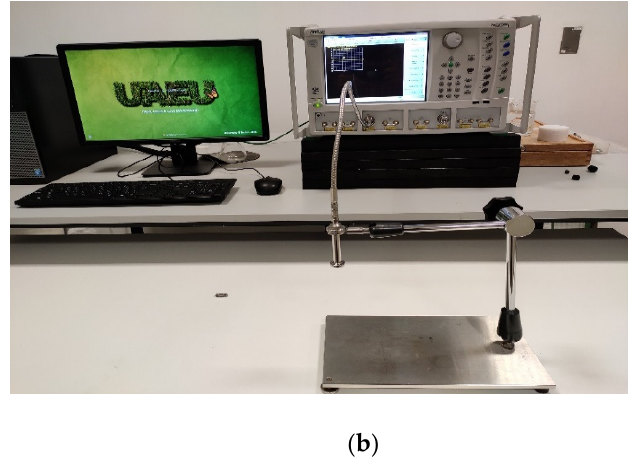
Figure 5. ( a ) Instrument setup for the measurement. ( b ) Measurement setup used in our lab.